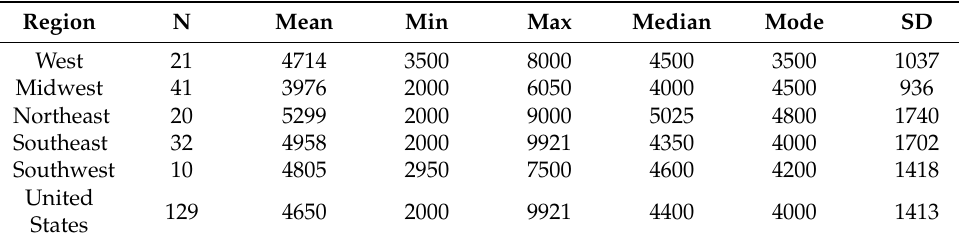
Table 1. U.S. Home Birth Fees by Region. (All fees are in